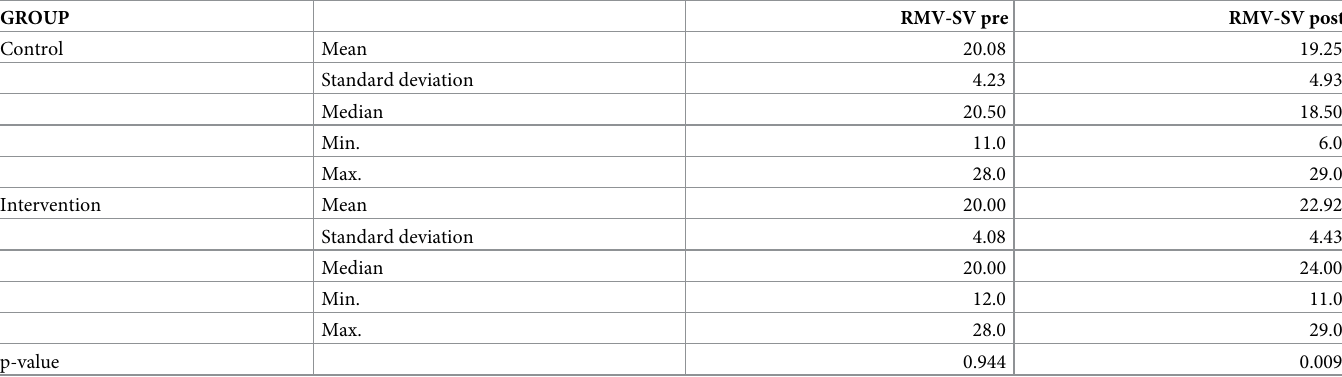
Table 7. RMV-SV values before and after the voices rehabilitation.